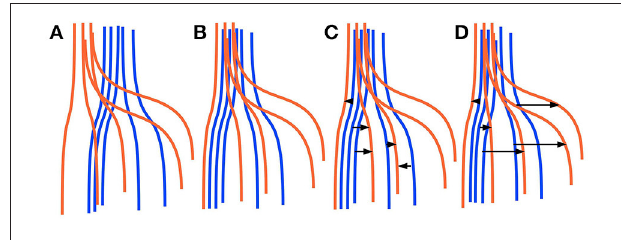
FIGURE 1 | Simplified sketch of streamline correspondence showing the difference between nearest neighbor vs. the proposed linear assignment problem (LAP). In blue and red we show two sets of 5 homologous streamlines each, before registration (A) , after initial registration (B) , with arrows showing the correspondence from the blue streamlines to red ones with nearest neighbor (NN) (C) and with streamline correspondence with LAP (D) . NN (C) misses the two streamlines on the right side, while LAP (D) does